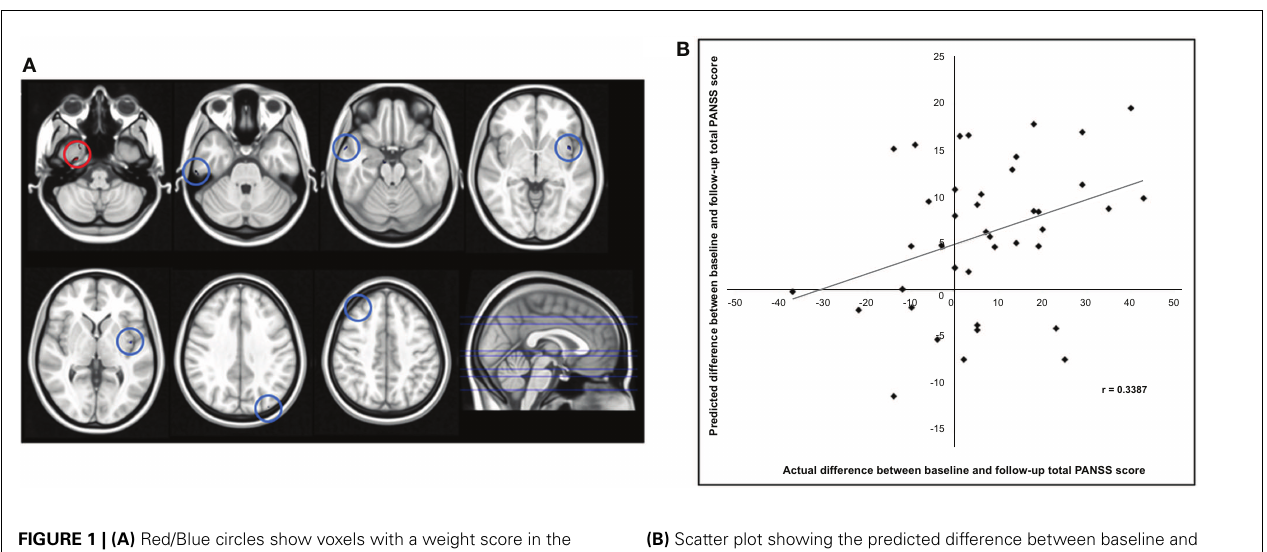
FIGURE 1 | (A) Red/Blue circles show voxels with a weight score in the top/bottom 30% of the maximum (range − 0.011608 to –0.026588). Axial Slices (MNI) Left-Right: − 65, − 49, − 40, − 23, − 17, 16, 25.